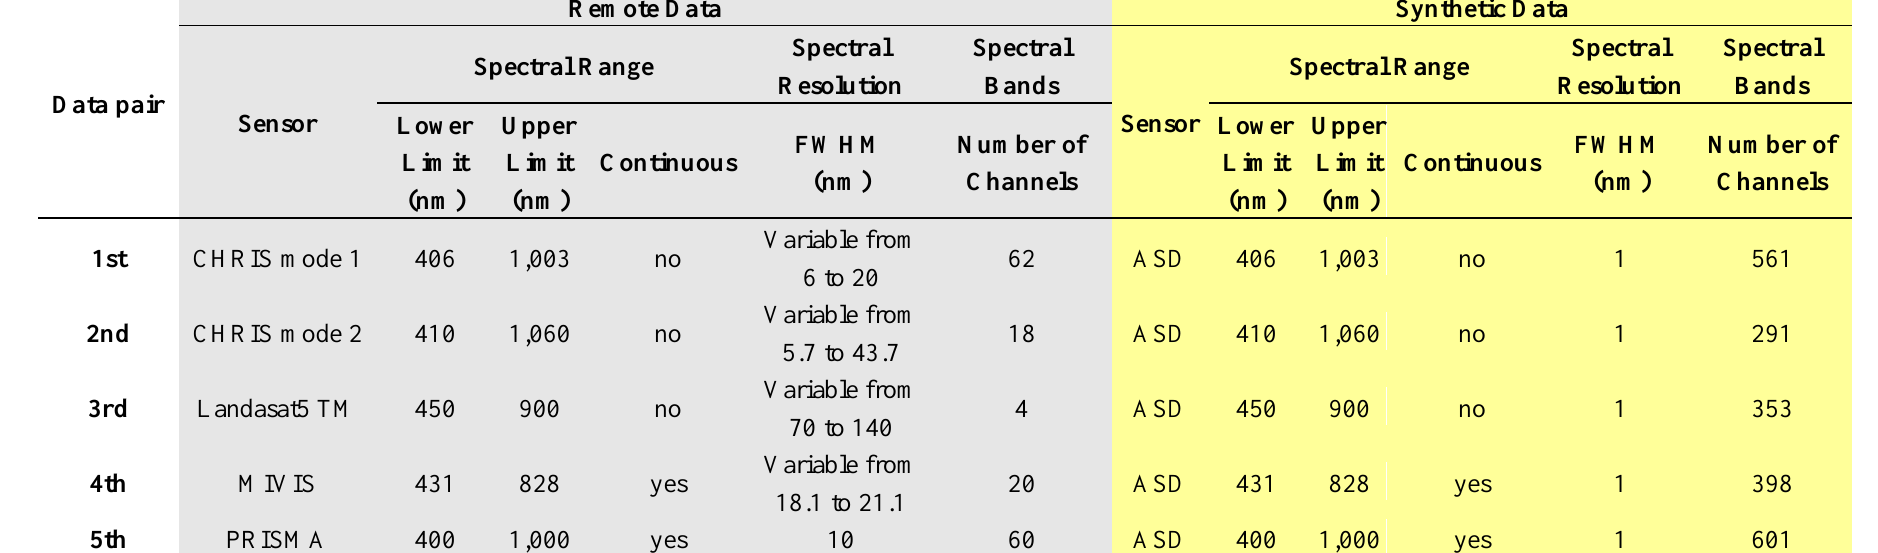
Table 2. The spectral characteristics of the remote data and the corresponding synthetic data are shown. Each row describes the two elements of each pair. The first group of six columns, in grey, summarizes the spectral characteristics of the remote data for each pair of data. The second group of six columns, in yellow, highlights the spectral characteristics of the synthetic data corresponding to the remote data for each pair of data. The spectral ranges of the CHRIS mode 1, the CHRIS mode 2, the Landasat5 TM and their corresponding synthetic data are not continuously